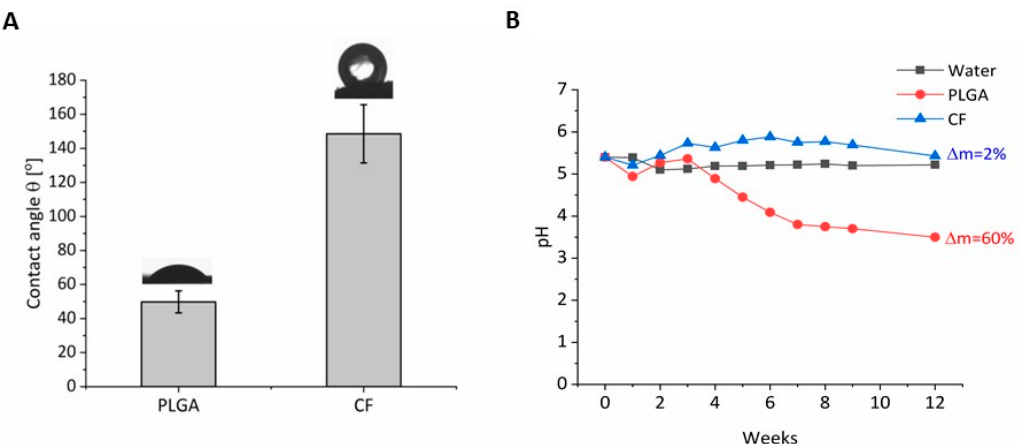
Figure 2 . ( A ) Water contact angle for both types of fiber. The shape of the drops indicates the hydrophilic (PLGA) and hydrophobic (CF) nature of the surface of the materials. ( B ) Change in the pH of incubated fibers as a function of time.